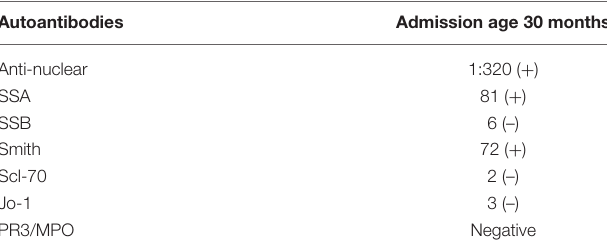
TABLE 2 | Auto-antibody